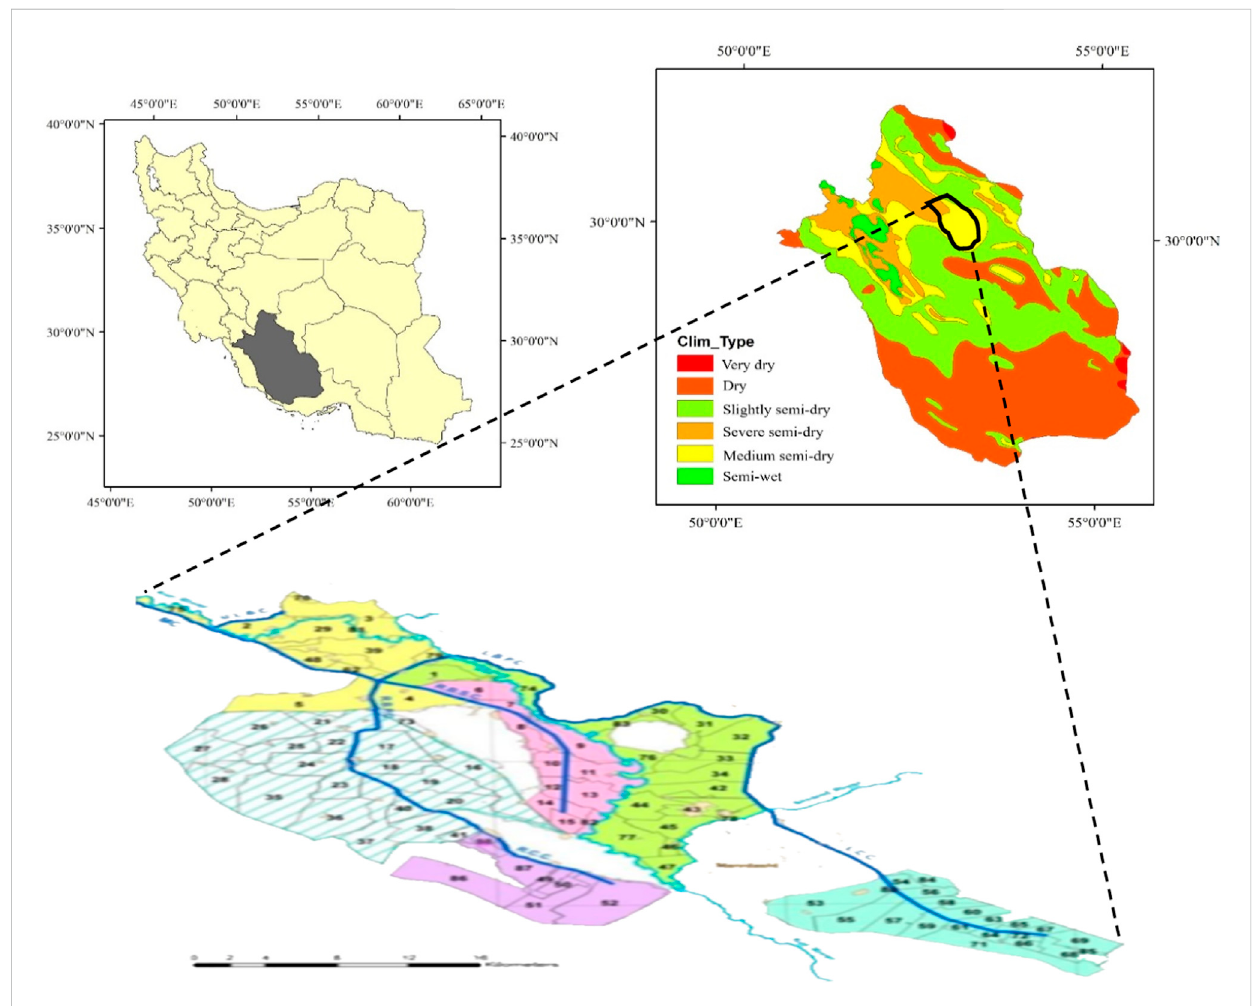
FIGURE 1 Location of irrigation network of doroodzan dam in fars province,